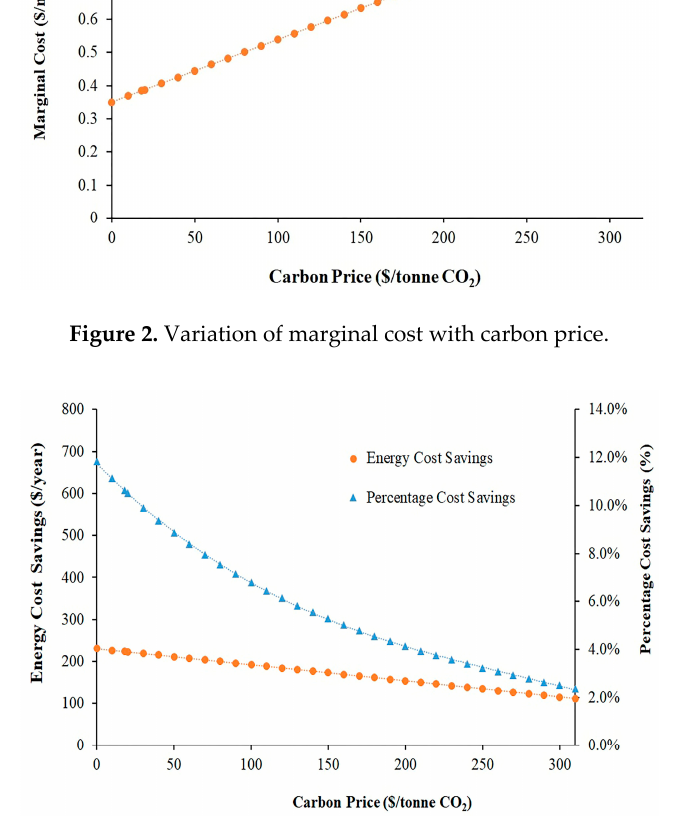
Figure 3. Variation of energy cost savings of GAHP with carbon